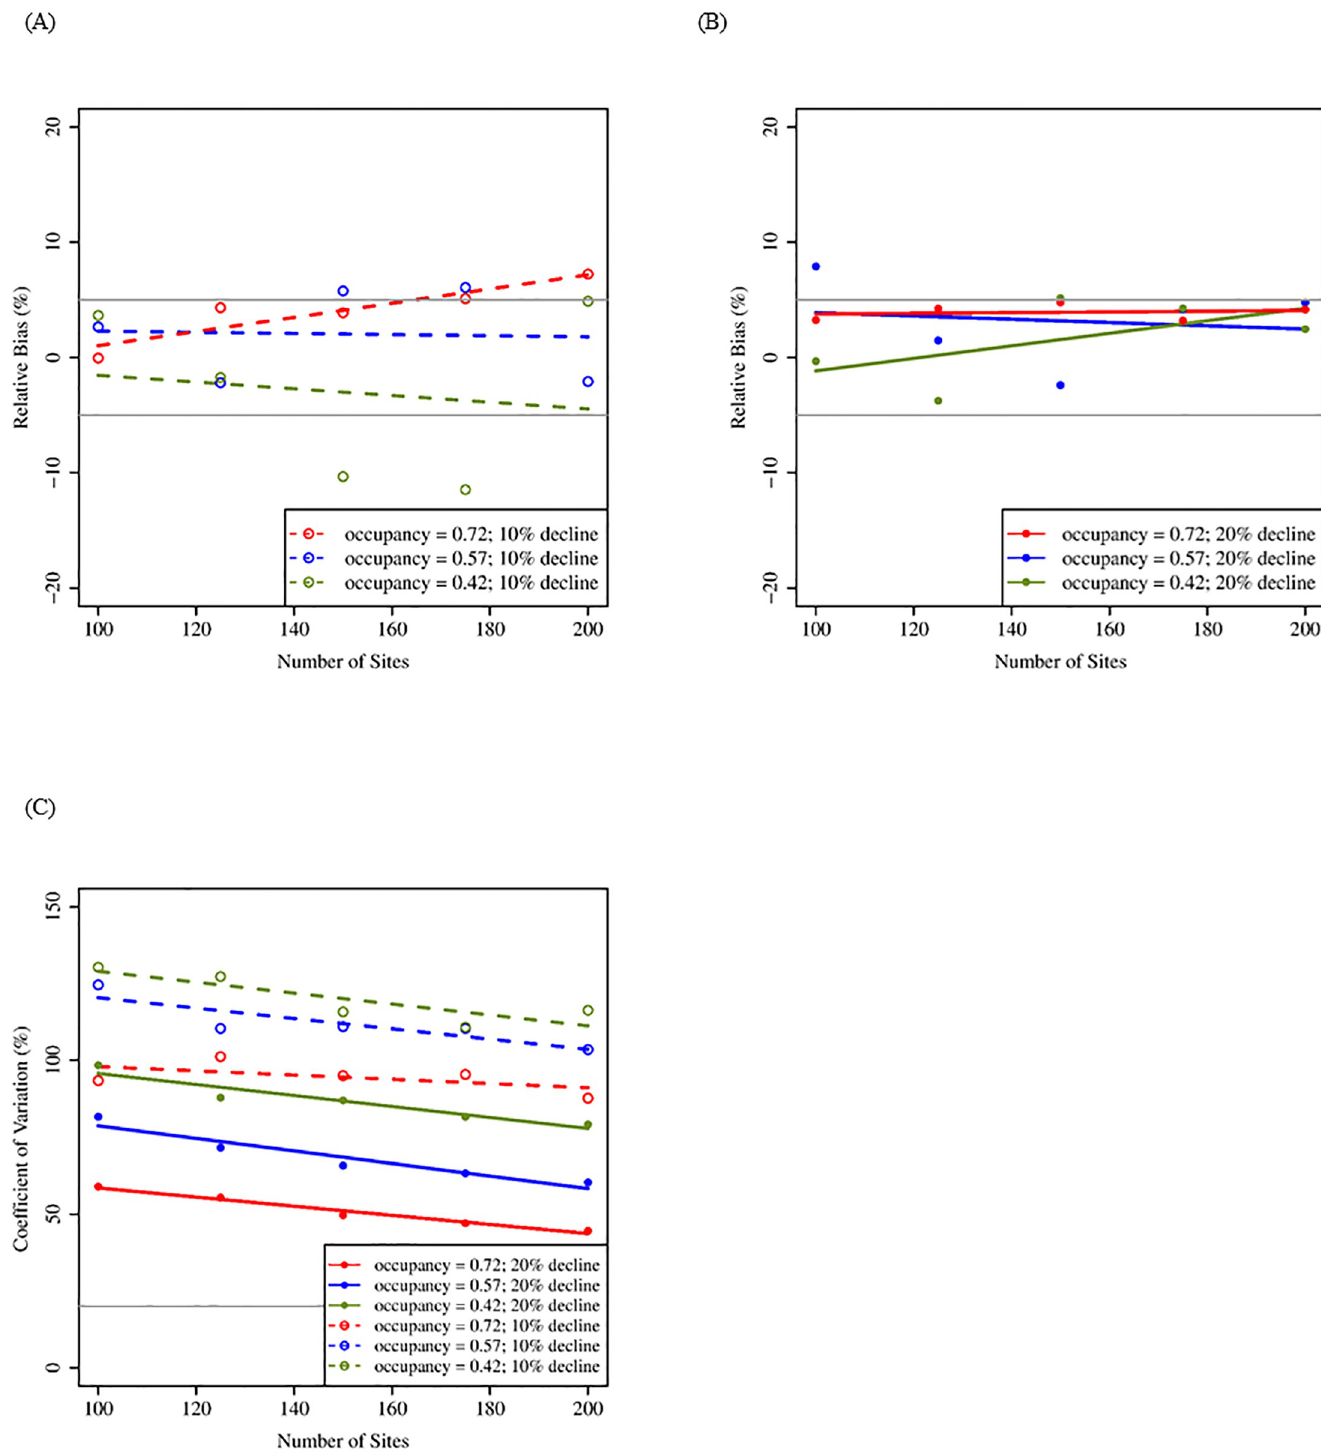
Fig 5. Mean relative bias and coefficient of variation for simulations increasing number of sites (standard design; 10 years). Mean relative bias (A: 10% decline; B: 20% decline) and coefficient of variation (C) for 100–200 sites, three occupancy rates, and two rates of population decline following a 10-yr monitoring period, assuming three visits and a probability of detection = 0.67. These results reflect a standard sampling design in which all territories are visited an equal number of times within a season. Gray lines indicate benchmark values for respective metrics (Table 2).